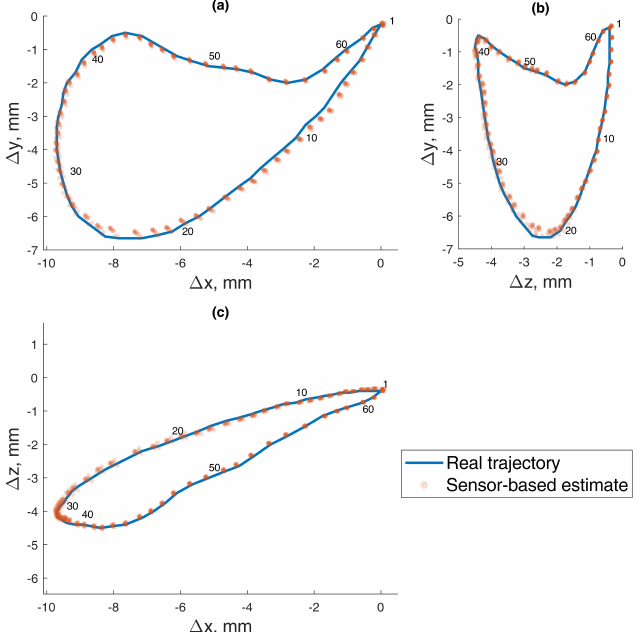
Figure 12. The 5–DOF masticatory test trajectory estimated with BMF compensation and angle compensation. Magnetic values at each point recorded with the sensor in the static state. Average RMSE = 0.17 mm, ED = 0.10 mm (Euclidian distance). Measured points are numbered 0 to 62, and all 10 iterations are represented in transparent markers. ( a ) Lateral–vertical view ( x – y ). ( b ) Protrusive– vertical view ( z – y ). ( c ) Lateral–protrusive view ( x – z